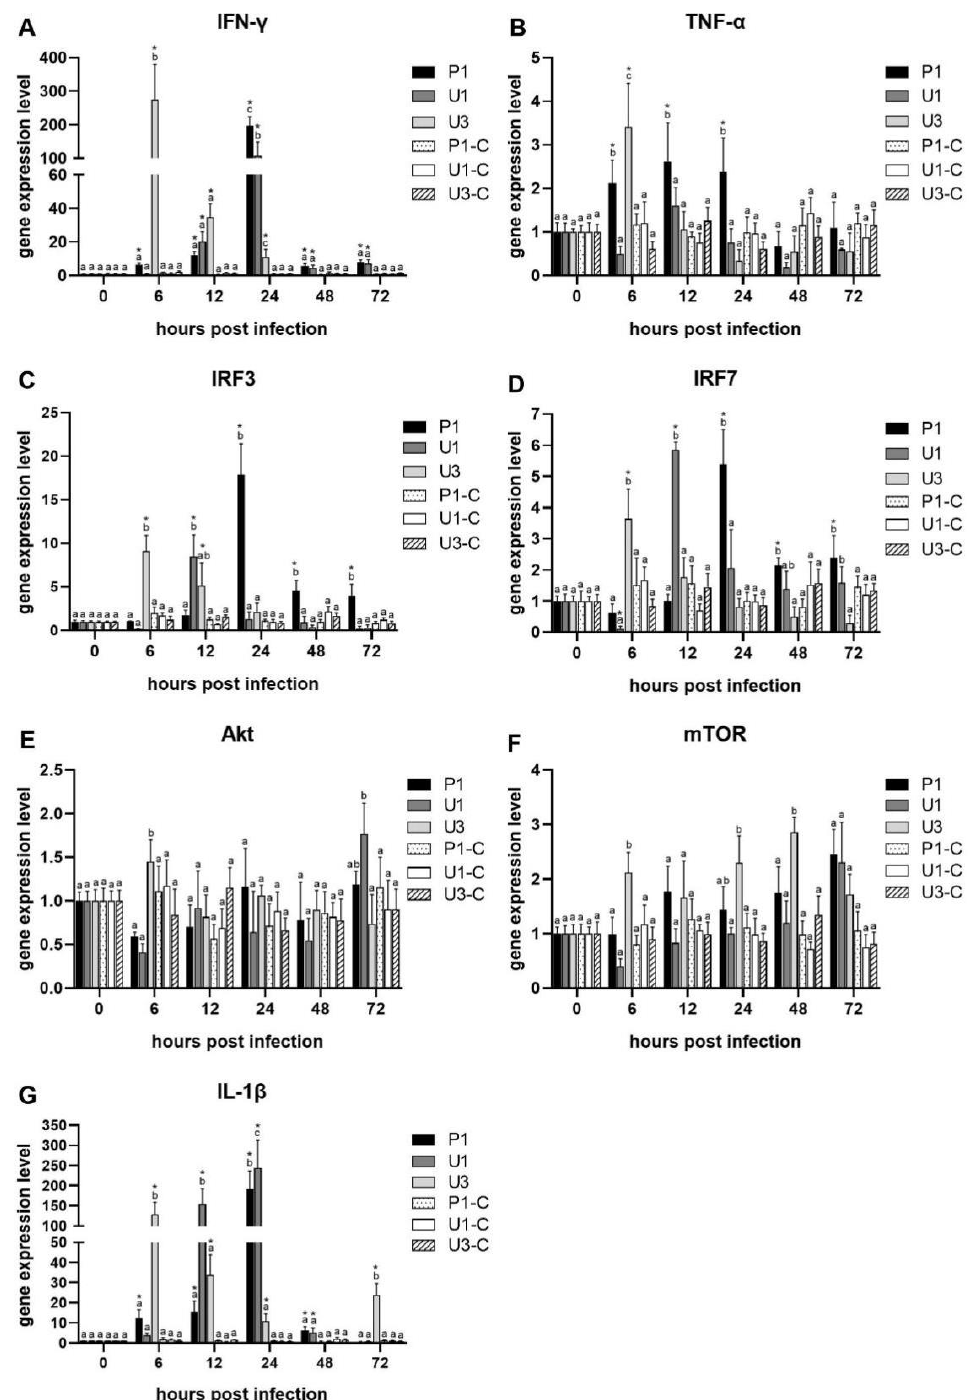
Figure 3. The gene expression level of IFN- γ ( A ), TNF- α ( B ), IRF3 ( C ), IRF7 ( D ), Akt ( E ), mTOR ( F ), and IL-1 β ( G ) in the spleen of largemouth bass in the P1, U1, and U3 groups infected with MSRV, and P1-C, U1-C, and U3-C groups injected with PBS. Different letters indicate significantly different between different groups at the same sampling time ( p < 0.05). * Indicate significantly different between 0 h and other sampling time of the same group ( p < 0.05).